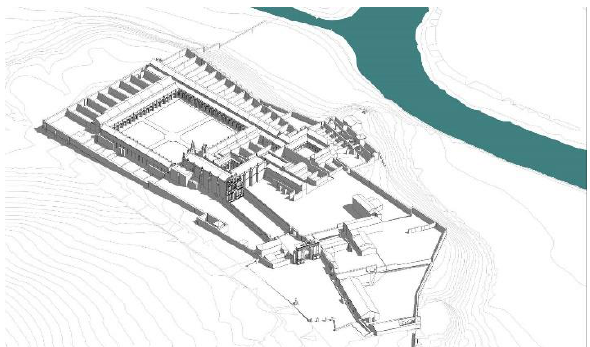
Figure 1: HBIM Charterhouse of Jerez, phase 07